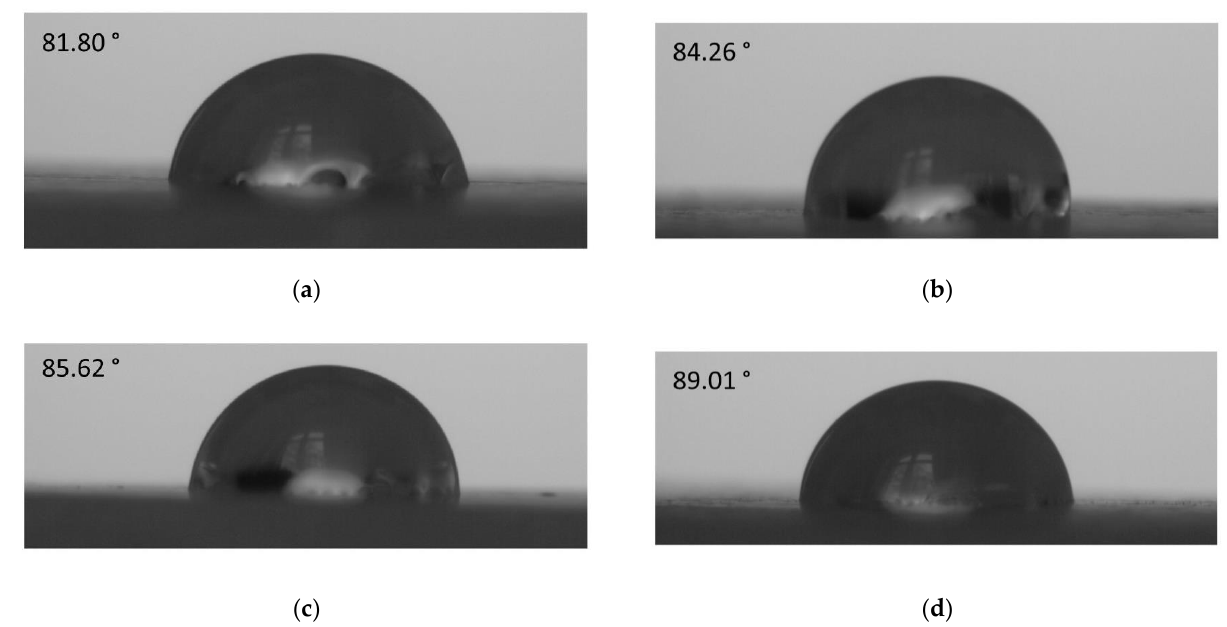
Figure 12. The images of deionized water droplets on the studied surfaces obtained from the goniometry camera for the ( a ) neat polymer, ( b ) material containing 0.5 wt.% QA-PEI-NPs, ( c ) material containing 1 wt.% QA-PEI-NPs, and ( d ) material containing 2 wt.% QA-PEI-NPs.